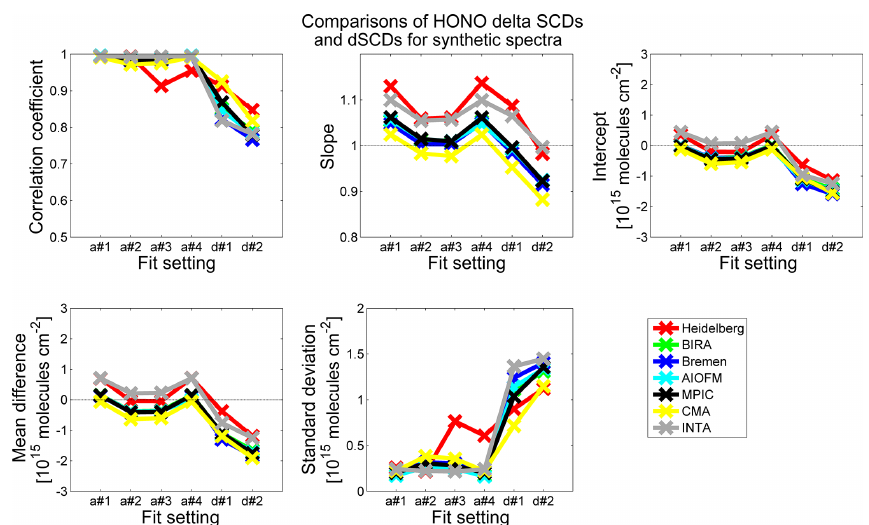
Figure 8. Correlation coefficients, slopes and intercepts of linear regressions as well as mean differences and standard deviations derived from the comparisons of the HONO delta SCDs and dSCDs between retrieved from the V1 synthetic spectra and the simulated real values as function of the DOAS fit setting number for individual institutes. The colour curves indicate different institutes. “a#1”, “a#2”, “a#3” and “a#4” in the labels of the x axis indicate the HONO delta SCD retrieved by fits with DOAS setting #1, #2, #3 and #4 (see Table 4), respectively. And “d#1” and “d#2” indicate the HONO dSCDs retrieved by fits with DOAS setting #1 and #2,